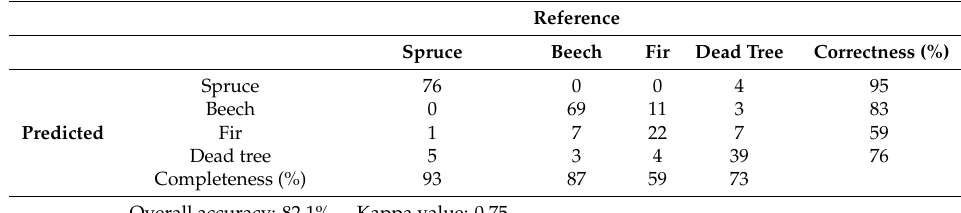
Table 6. Confusion matrix of scenario 4 using features extracted from multi wavelength ALS point cloud from the test data set.